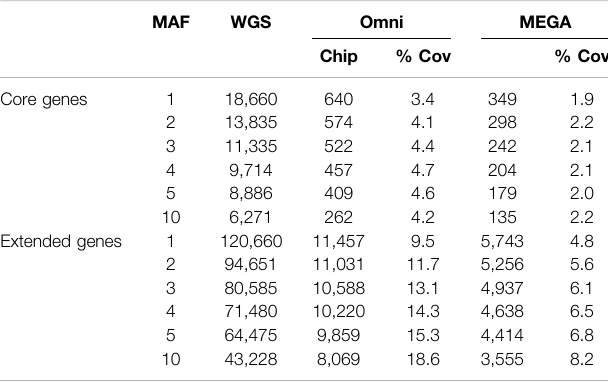
TABLE 5 | Variant coverage and overlap for core and extended gene variants detected in HAAD whole genome sequencing datasets vs those captured by the Omni 2.5.8 and the MEGA